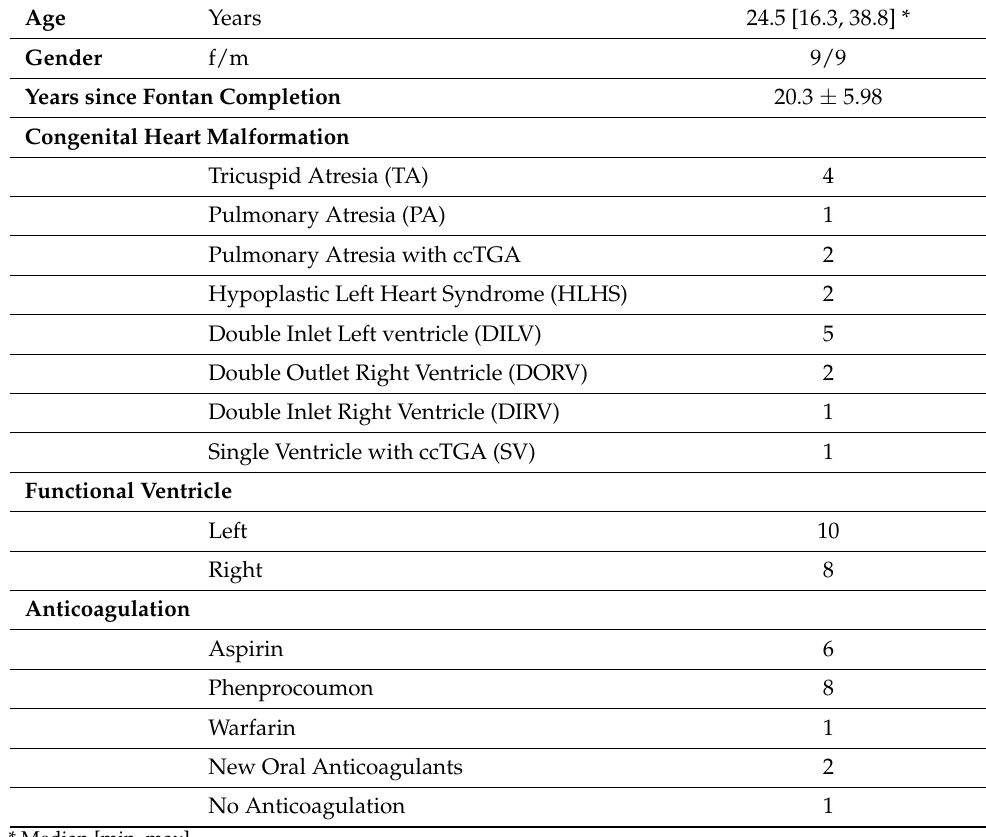
Table 1. General characteristics of participating patients with Fontan